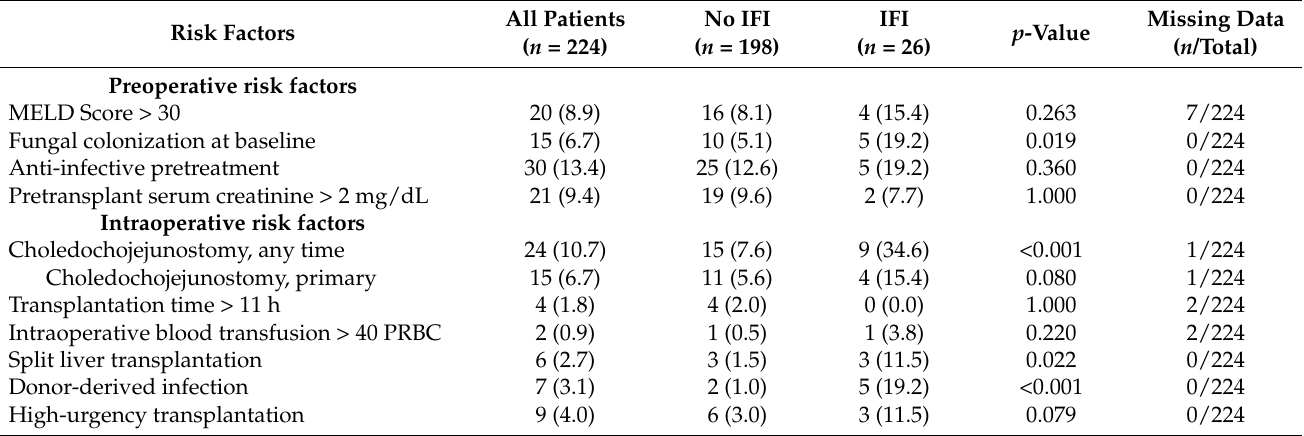
Table 3. Potential risk factors for an invasive fungal infection ( n =